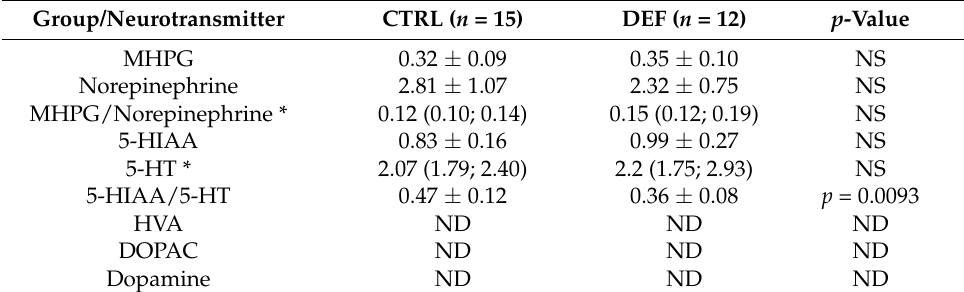
High performance liquid chromatography (HPLC) detection of monoaminergic neurotransmitters in the